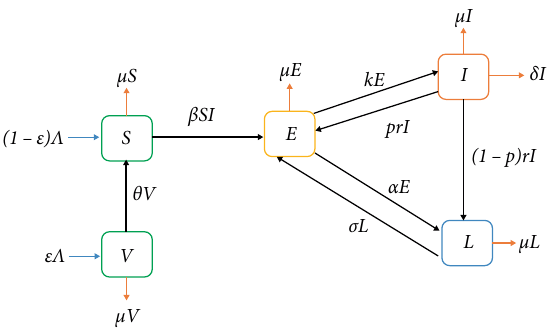
Figure 1: Flow diagram of the TB transmission